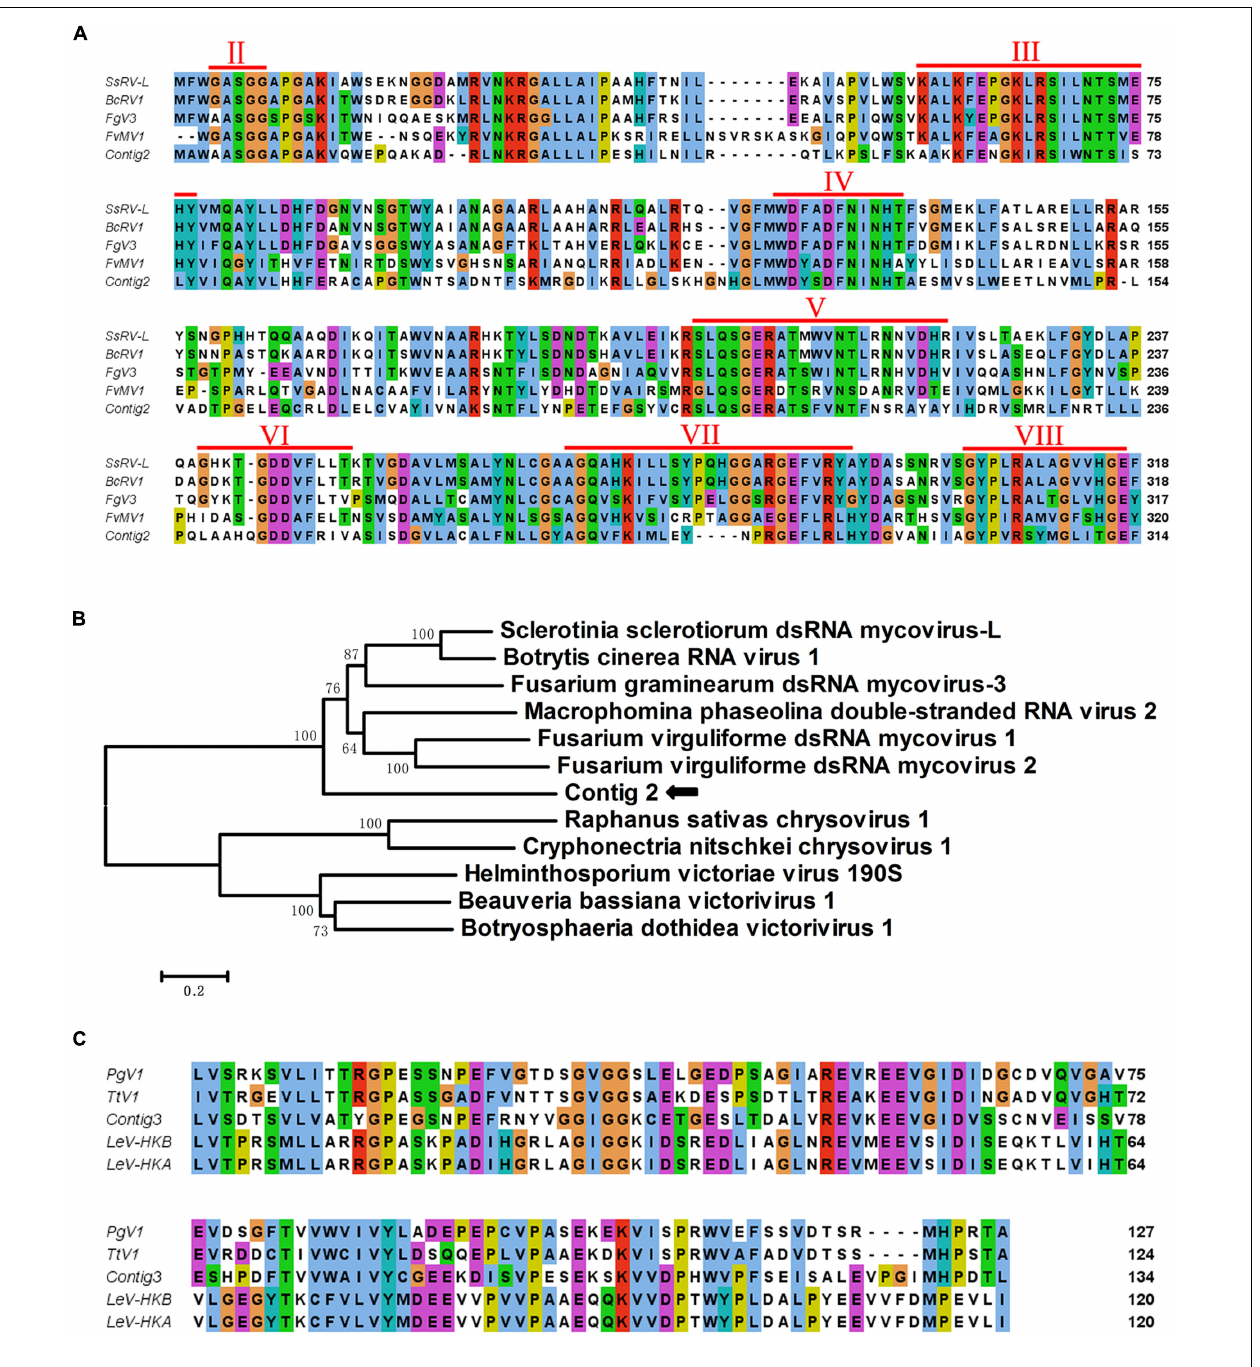
FIGURE 9 | Multiple alignment of contig 2 and contig 3 translated amino acid sequences and phylogenetic analysis of the contig 2 encoded protein. (A) Multiple alignment of the viral RNA-dependent RNA polymerases (RdRp) encoded by contig 2 and other similar dsRNA mycoviruses. Conserved sequence motifs (denoted by numbers II to VIII) characteristic of the RdRps of dsRNA mycoviruses are indicated. The alignment was prepared by the program CLUSTAL_X and viewed by Jalview. (B) A phylogenetic tree was constructed based on the alignment of the contig 2-encoded RdRp and selected viruses. The phylogenetic analysis was conducted with the neighbor-joining method using MEGA 6, with bootstrap of 1000 replicates. (C) The NUDIX domain was shown by multiple alignments of aa sequences of contig 3 and its related mycoviruses. The viral names and accession numbers for the above analysis are as follows: SsRV-L, Sclerotinia sclerotiorum dsRNA mycovirus-L (CEZ26307.1); BcRV1, Botrytis cinerea RNA virus 1(YP_009115498.1); FgV3, Fusarium graminearum dsRNA mycovirus-3 (YP_003288789.1); FvMV1, Fusarium virguliforme dsRNA mycovirus 1 (AEZ54148.1); FvMV2, Fusarium virguliforme dsRNA mycovirus 2 (AEZ54146.1); RsSCV1, Raphanus sativas chrysovirus 1 (AFE83590.1); CnCV1, Cryphonectria nitschkei chrysovirus 1 (ACT79256.1); HvV 190S, Helminthosporium victoriae virus 190S (NP_619670.2); BbV1, Beauveria bassiana victorivirus 1(CCC42235.1); BdV1, Botryosphaeria dothidea victorivirus 1 (YP_009072433.1); PgV1, Phlebiopsis gigantea mycovirus dsRNA 1 (YP_003541122.1); TtV1, Thelephora terrestris virus 1(YP_009209481.1); LeV-HKB, Lentinula edodes mycovirus HKB (BAG71789.2); LeV-HKA, Lentinula edodes mycovirus HKA (BAM34027.1).